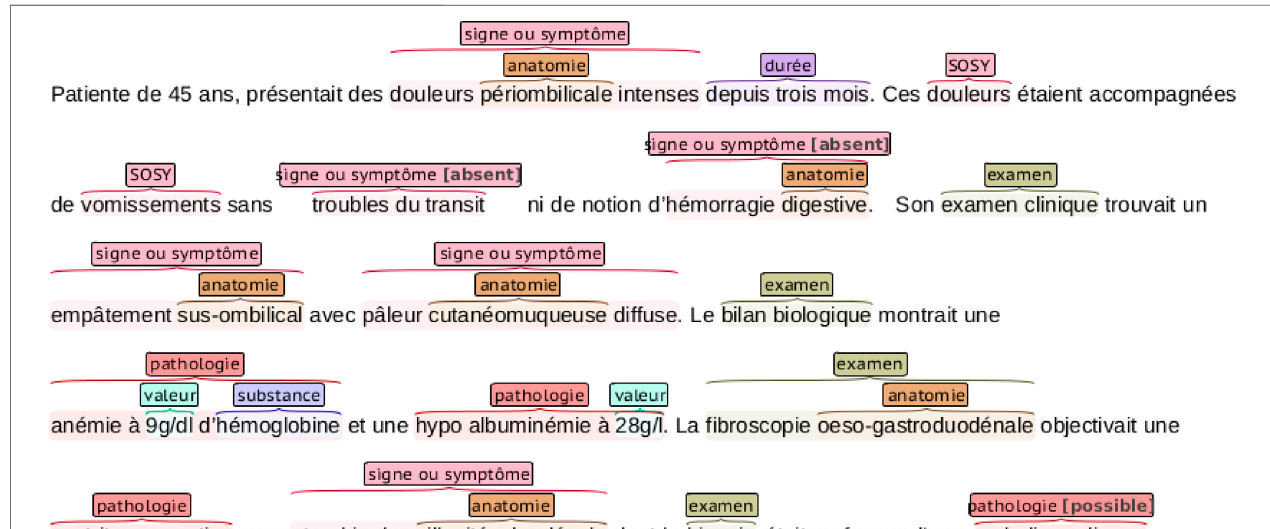
FIGURE2| Anexample ofaclinicalnarrativeoftheDEFTdataset withentityannotations.Theannotationsarecolor-coded, representingthedifferententitiesinthe dataset. Notice that some entities are nested.